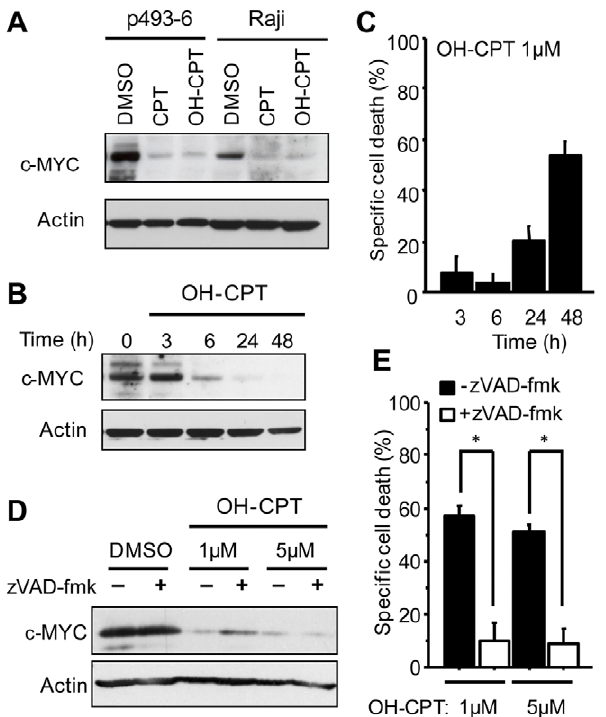
Figure 4. c-MYC down-regulation upon topoisomerase I inhibition precedes cell death induction. ( A ) Western blot of c- MYC expression in p493-6 and Raji cells after 48 h treatment with 1 m M of the indicated drugs. ( B ) Western blot analysis of c-MYC expression in p493-6 cells before and after treatment for indicated times with 1 m M of 10-OH-Camptothecin. ( C ) Cell death induction as measured by propidium iodide staining and quantification of cells with subG1 DNA content after treatment for indicated times with 1 m M of 10-OH- Camptothecin. Data are shown as specific cell death induction relative to control (DMSO) treated cells and represent the means of three independent experiments. Error bars indicate standard deviation. ( D ) Western blot analysis c-MYC expression in p493-6 treated for 48 h with topoisomerase inhibitors in the presence or absence of the pan-caspase inhibitor zVAD-fmk. ( E ) Cell death induction as measured by propidium iodide staining and quantification of cells with subG1 DNA content of cells treated with topoisomerase inhibitors in the presence or absence of the pan-caspase inhibitor zVAD-fmk for 48 h. Data are shown as specific cell death induction relative to control (DMSO) treated cells and represent means from three independent experiments. Error bars indicate standard deviations. * p , 0.01.